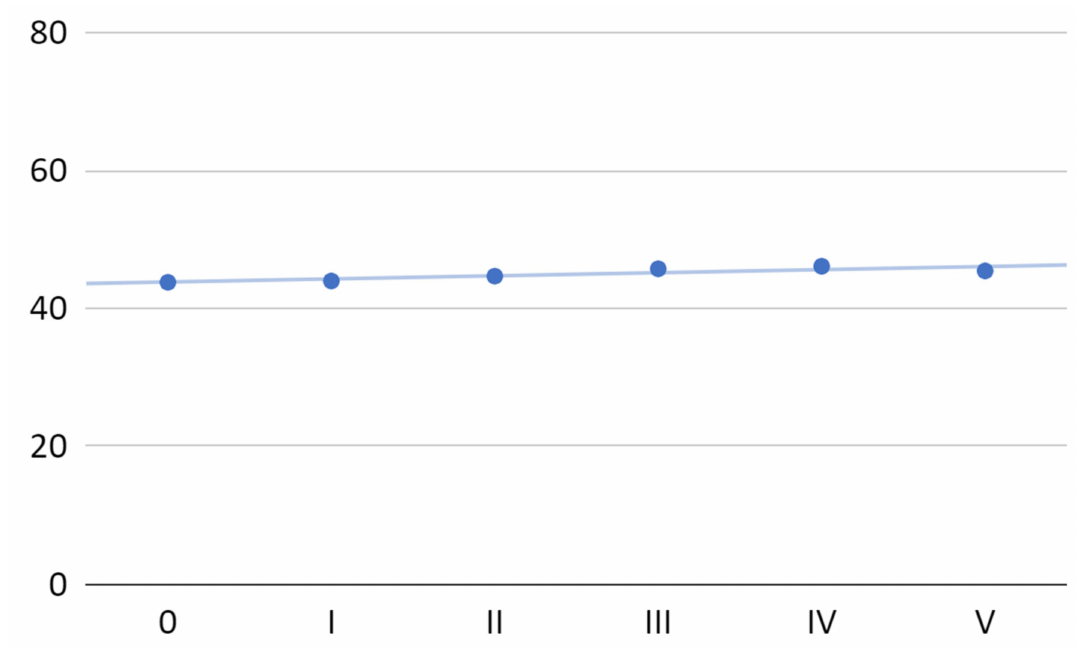
Figure 4. Mean maximum mouth opening at individual